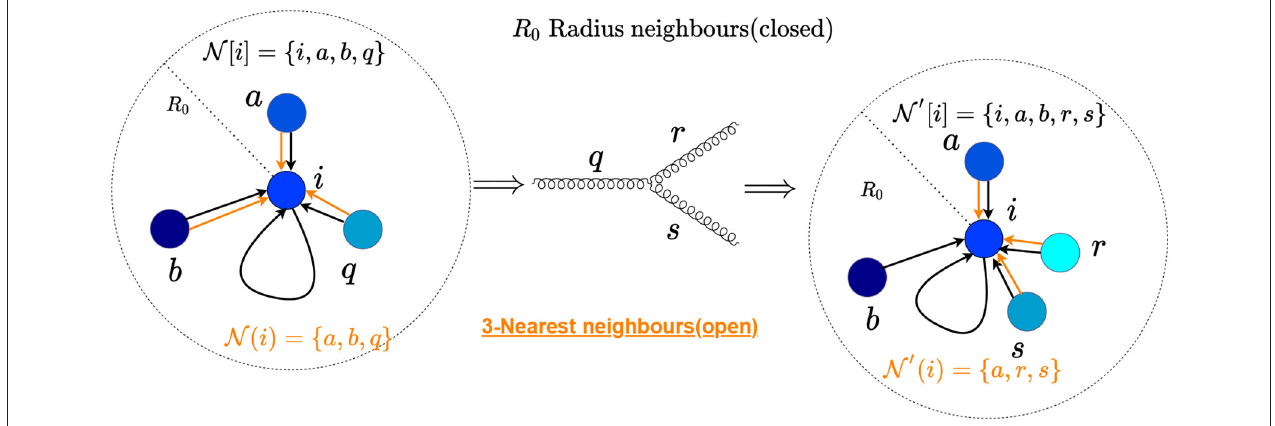
FIGURE 1 | Representation of radius graph with R 0 in the ( η , φ ) plane undergoing a QCD splitting. The black arrows correspond to the connections of a radius graph, while the red arrows highlight the 3-nearest neighbors connections. One can see that the radius neighborhoods have the same total energy, which is not the case for those obtained by the nearest neighbors method, leading to an IRC-unsafe